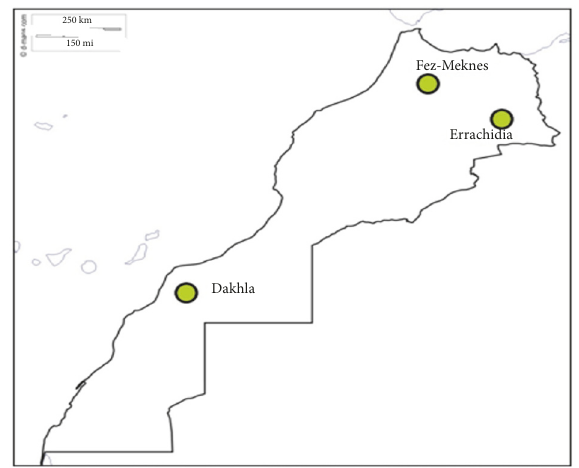
Figure 1: Geographic distribution of the three studied samples of Camel’s